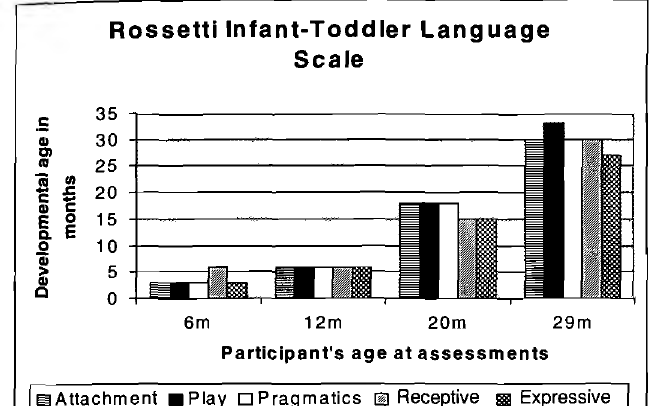
Figure 2: Participant's progress from 6-29 months on the Rossetti Infant-Toddler Language Scale (Rossetti, 1990).